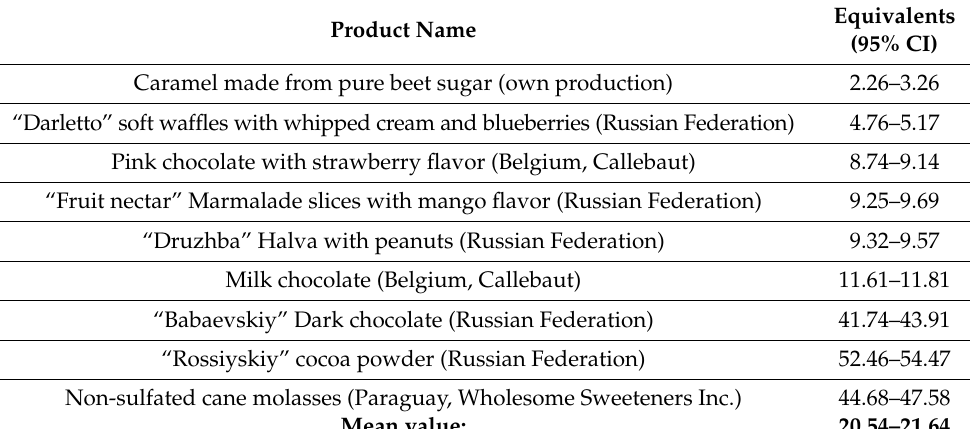
Table 3. ARP for candy products and some types of raw materials used in their